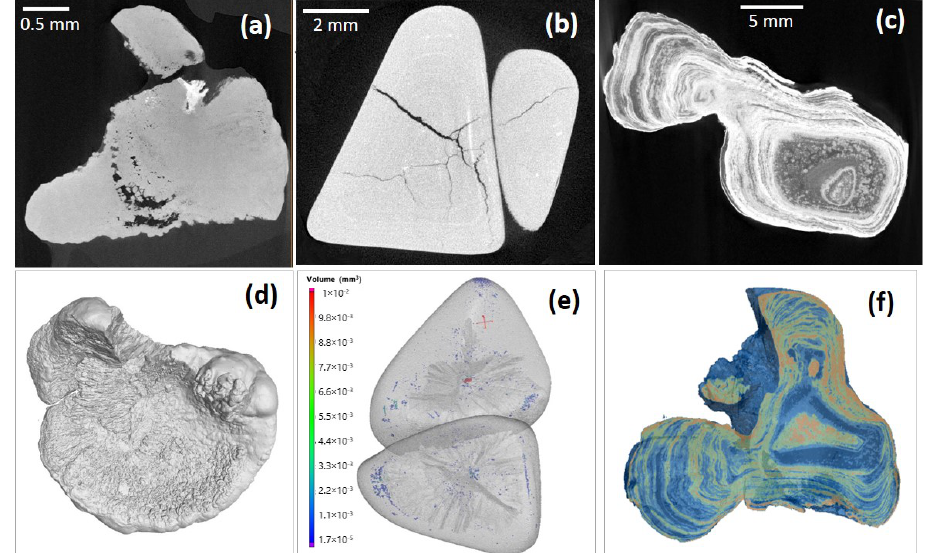
Figure 3. Reconstructed vertical slice of X-ray microtomography through three stone samples from ( a ) cat, ( b ) dog, and ( c ) human urinary stones. ( d – f ) Corresponding 3D rendering of the full stones in ( a – c ). In ( e ), the porosity size distribution is depicted by the side colorbar. The effective voxel sizes for the ( a – c ) microtomographs are 5.15, 12.86, and 39.9 µ m,